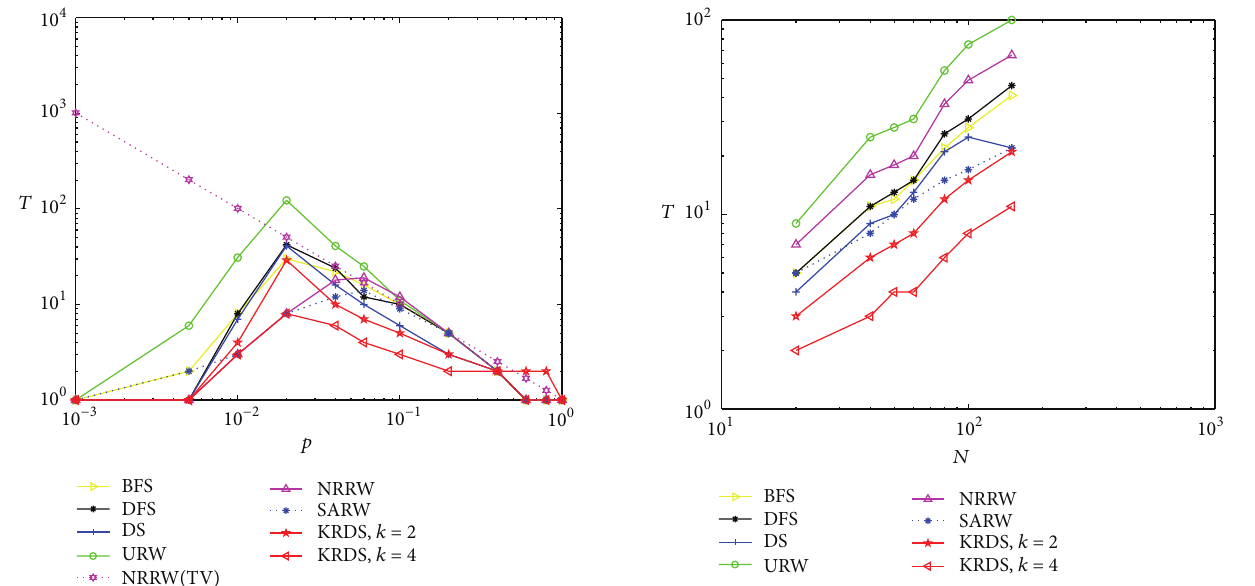
Figure 4: Plot of the average number 𝑇 of search steps versus the connection probability 𝑝 of ERRG in the log-log scale.